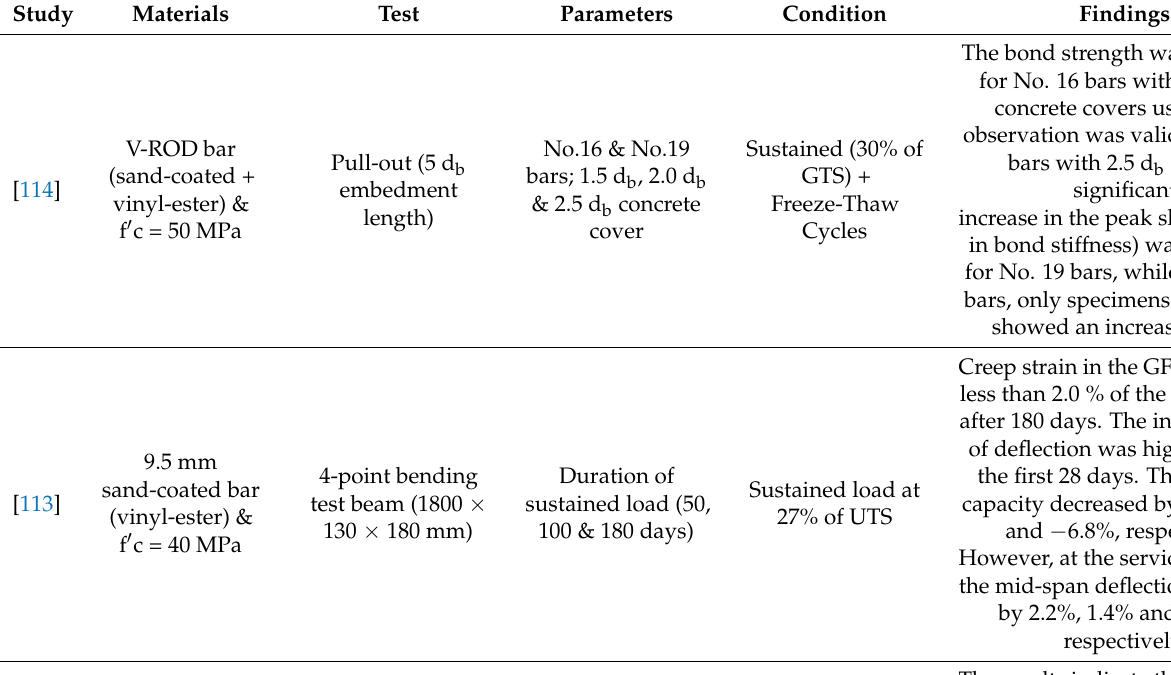
Table 4. Recent studies on creep in GFRP-RC